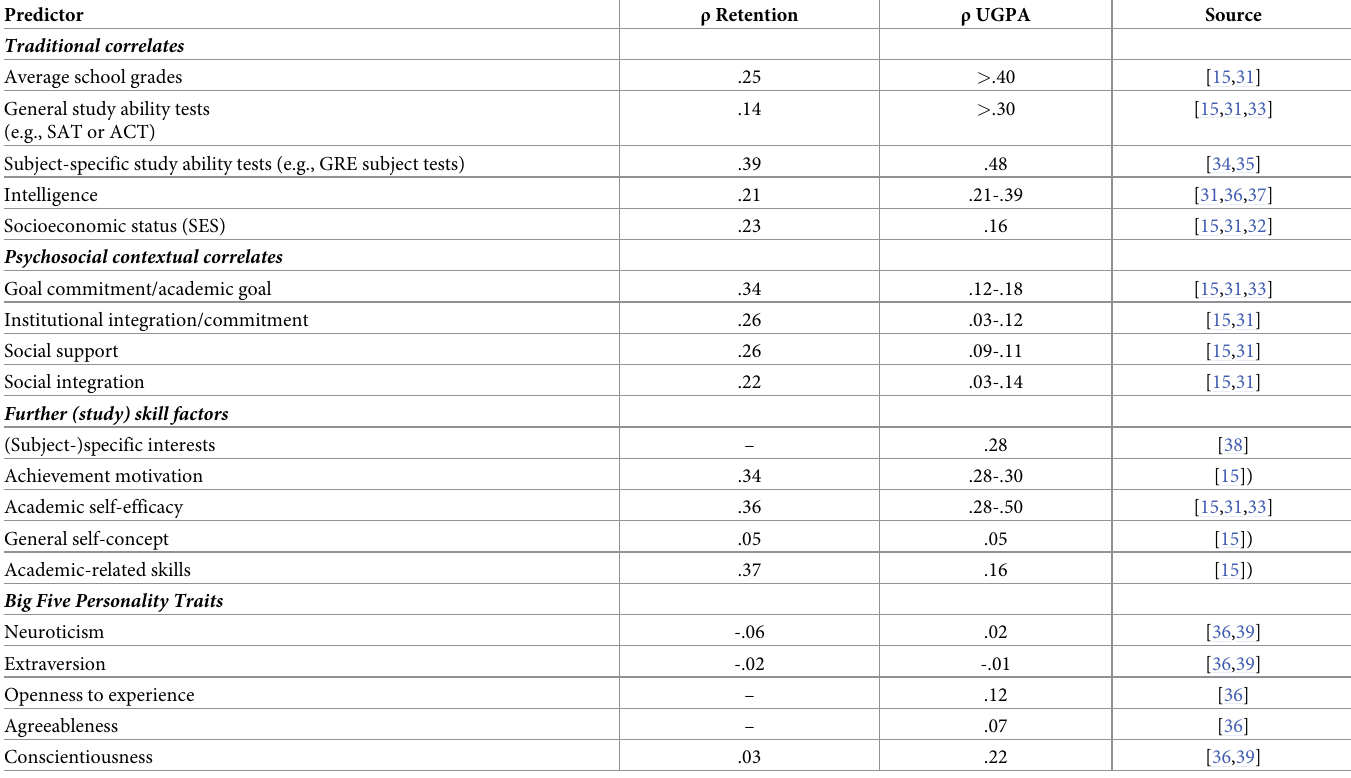
Table 1. Results of meta-analyses regarding the explanation of UGPA and student retention in higher